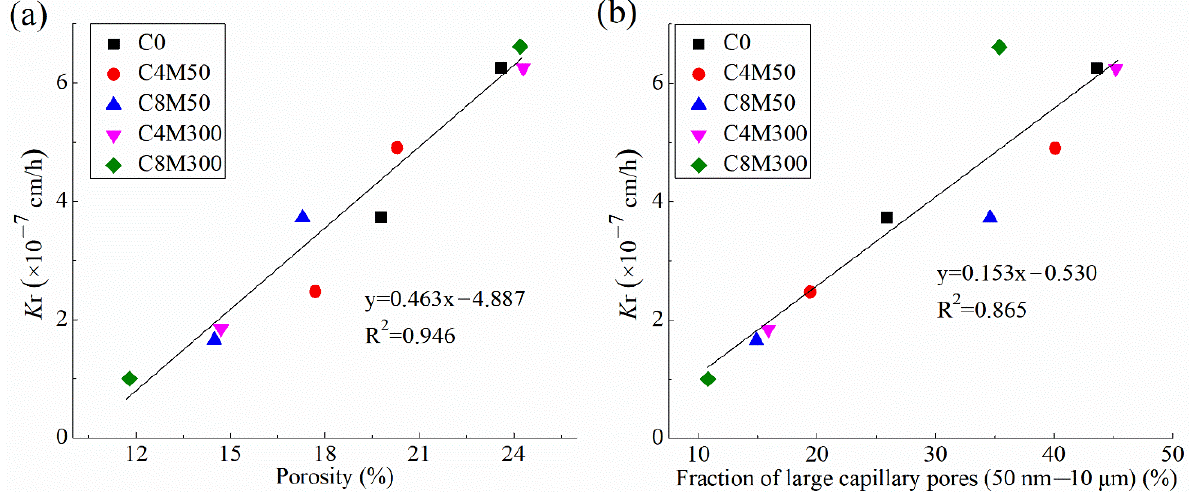
Figure 3. The correlations of relative permeability coefficient K r with ( a ) fraction of pores sized between 50 nm and 10 μm (large capillary pores) and ( b ) porosity.